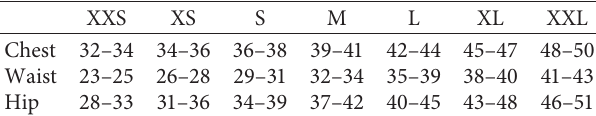
Table 1: Unisex size category for tops ∗ [18].